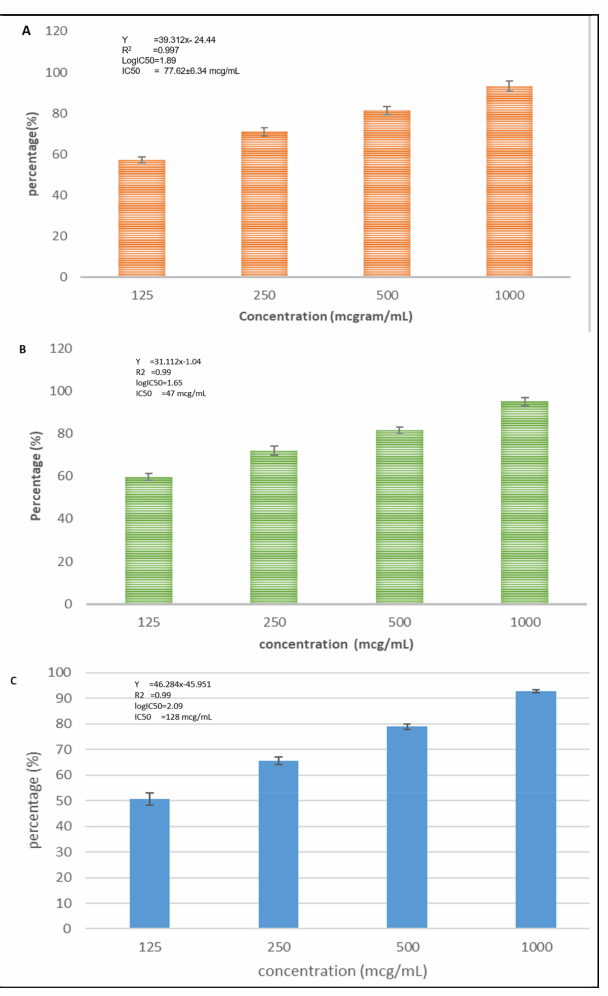
Figure 3. Inhibition activity of CXBCH preparation on T47D ( A ), Hela ( B ), and HTB-183 ( C ). The findings of the one-way mean difference test between concentrations According to an ANOVA analysis, the three cell types were tested with a p -value <